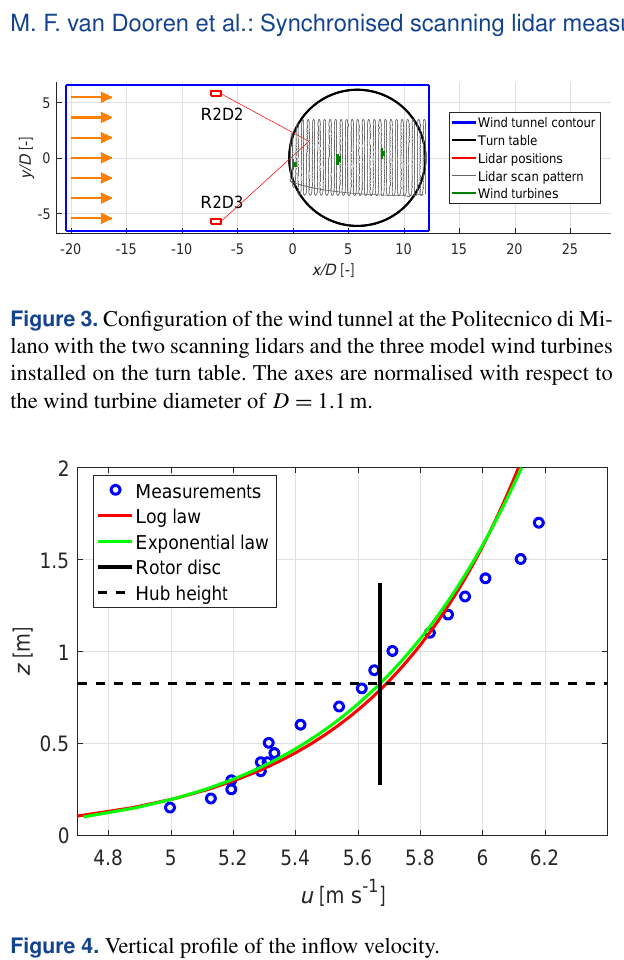
profile corresponds to a power law profile with a shear expo- nent of α = 0 . 09.